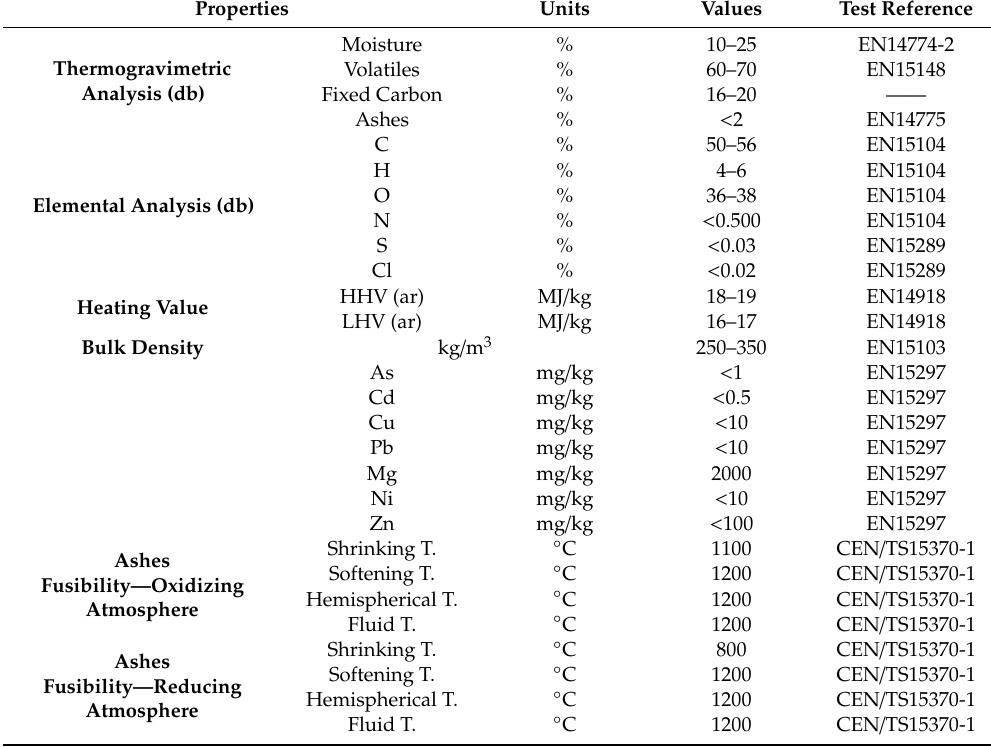
Table 2. Summary of the results obtained for raw materials used during the di ff erent phases of tests carried out between 2013 and 2016. Raw material was exclusively maritime pine